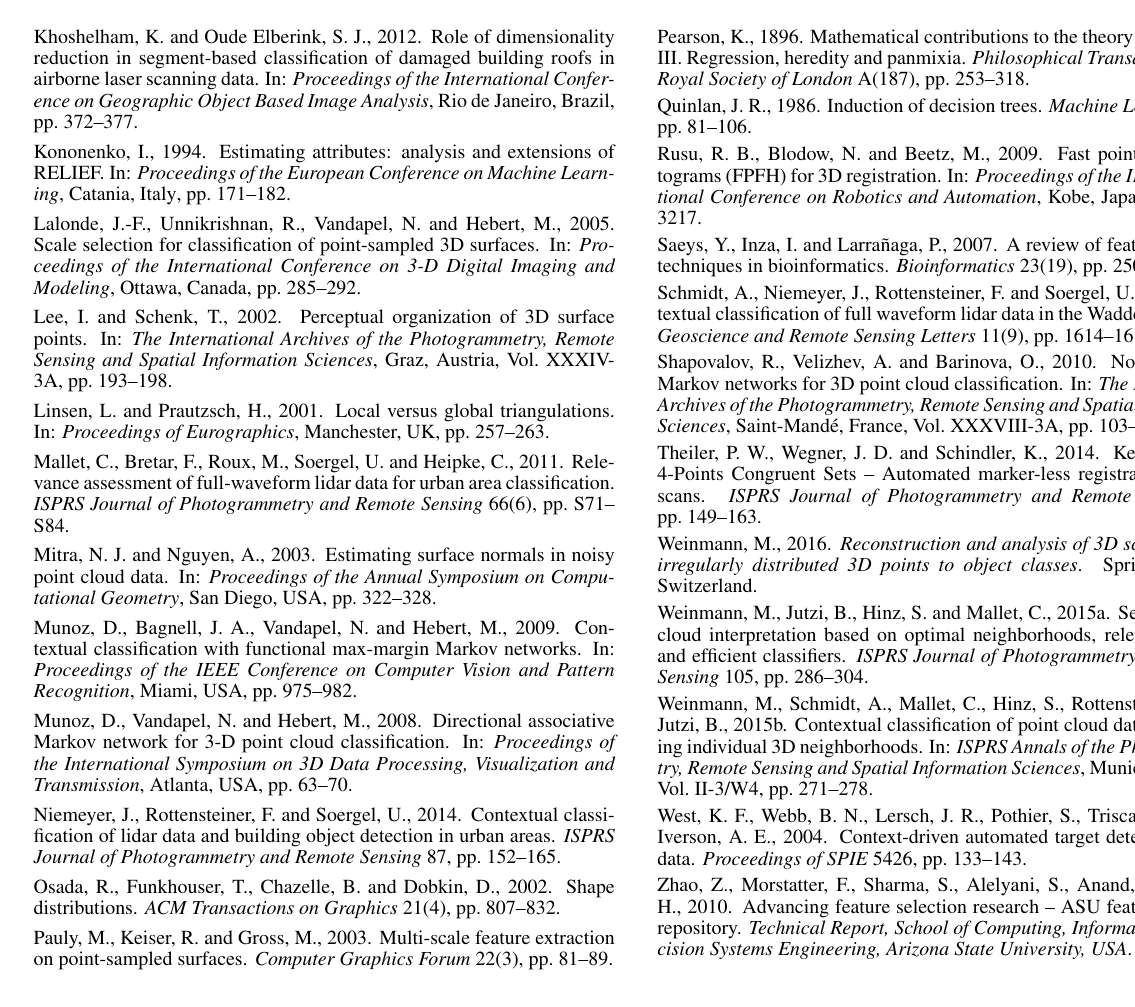
Figure 7. Feature relevance for Oakland-3C (top) and Oakland-5C (bottom) when using a reduced version of the voxel-grid-filtered training data ( 1 , 000 examples per class) and the neighborhood types N s, 1m (blue), N c, 1m (green), N k =50 (yellow) and N k